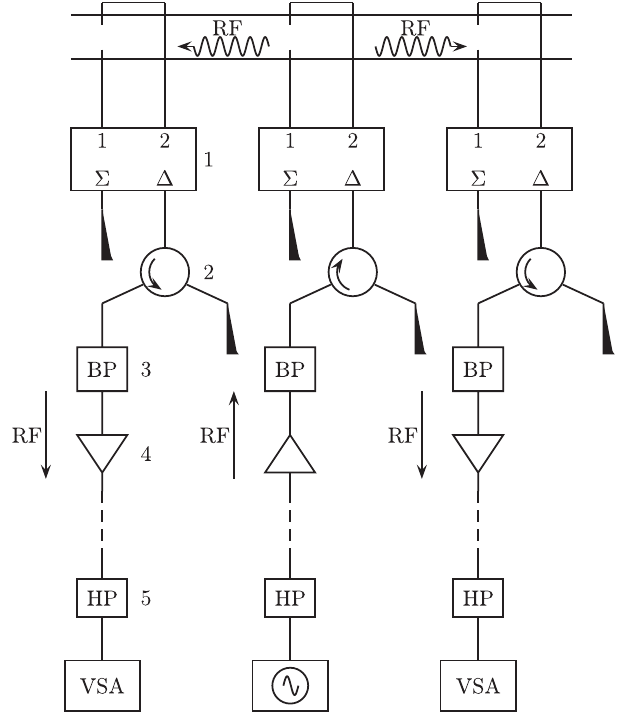
FIG. 3. Schematic layout of the SPS microwave transmission measurement. Each path consists of a hybrid (1), a circulator (2), a band-pass filter (3), an amplifier (4), and a high pass (5). The amplifier was powered by a Hameg Triple Power Supply HM 7042-5.